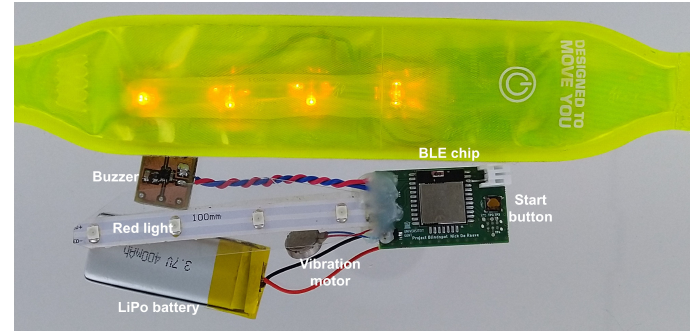
Figure 3. Designed wearable next to its